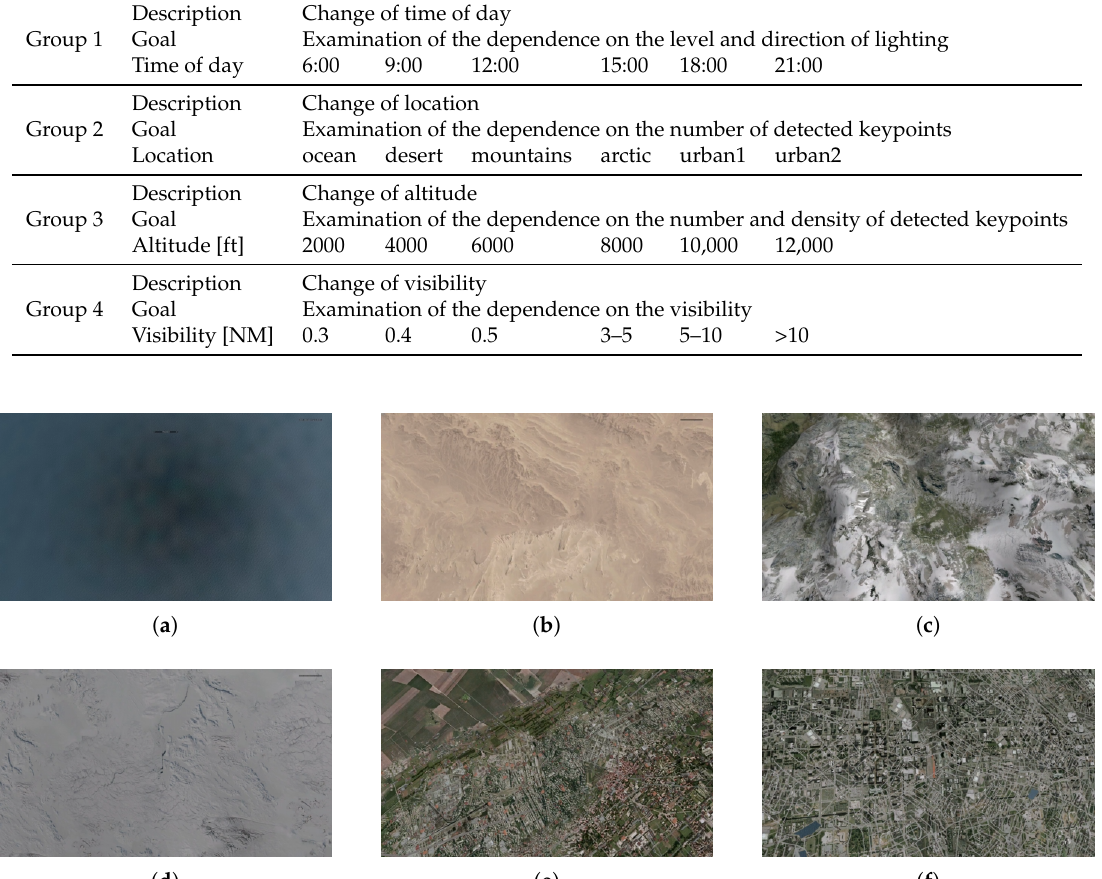
Table 1. Characteristics of the dataset.